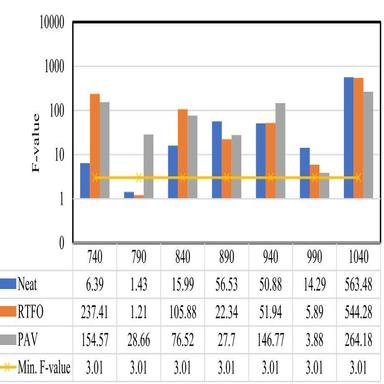
Statistical test results to evaluate the rubber dosage detection.